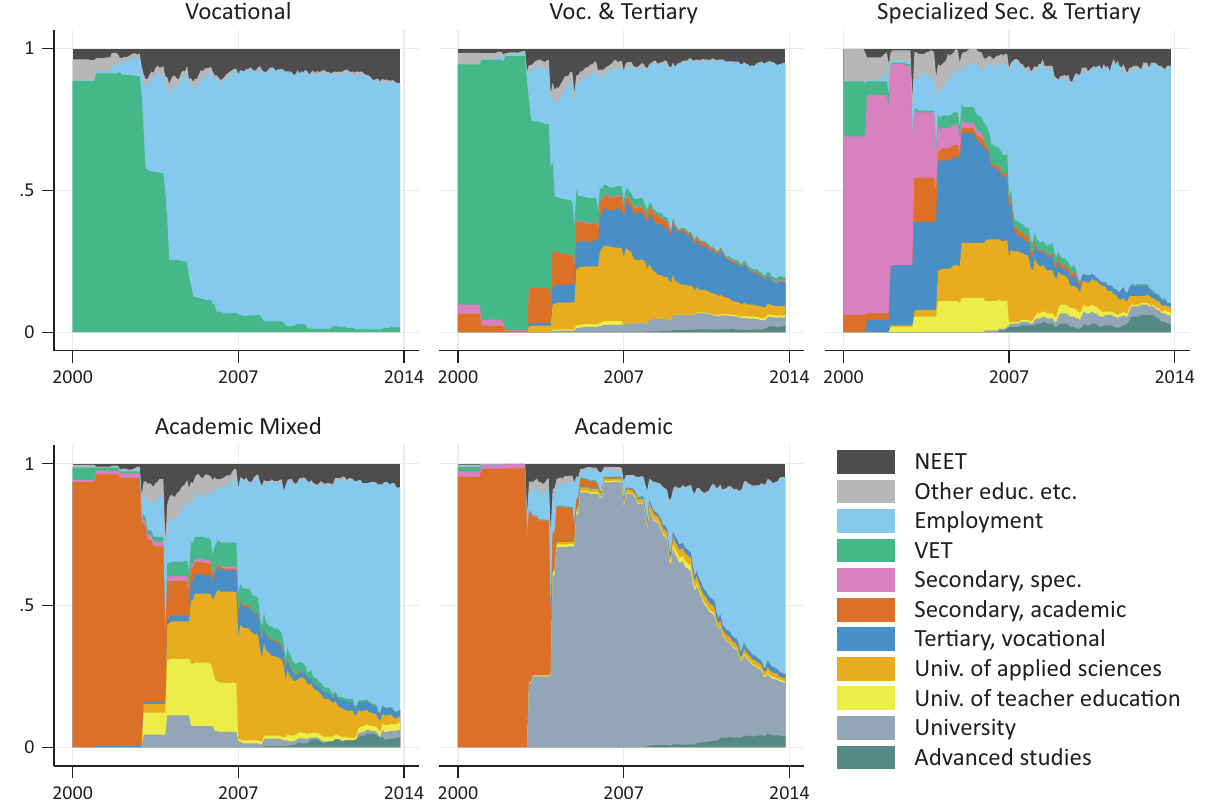
Figure 9. Clusters of educational trajectories, solution with a separate cluster for VET & employment. size of the two vocational clusters (the second cluster be- comes the biggest) but does not substantially change the results of the regressions (results not shown).